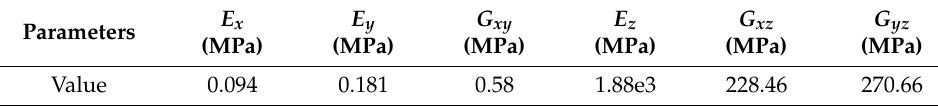
Figure 6. Deformation shape of FE model. Table 1. Properties of flexible honeycomb with overlying silicone skin.